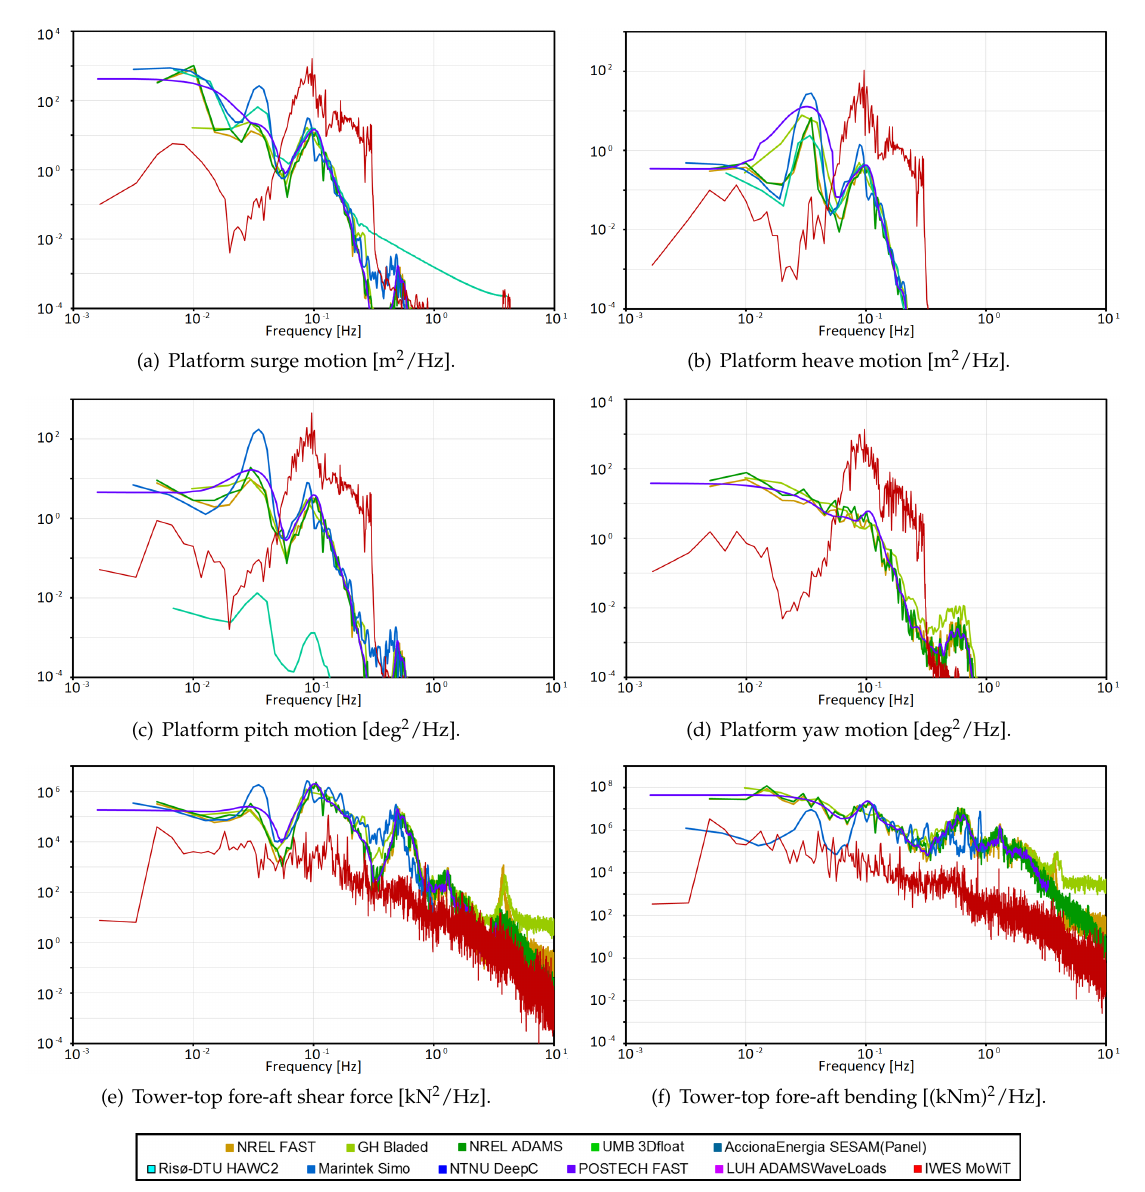
Figure 22. Aero-hydro-servo-elastic power spectra with irregular waves from LC 5.3, corrected for eliminating the deviations in the irregular wave and turbulent wind spectra, part